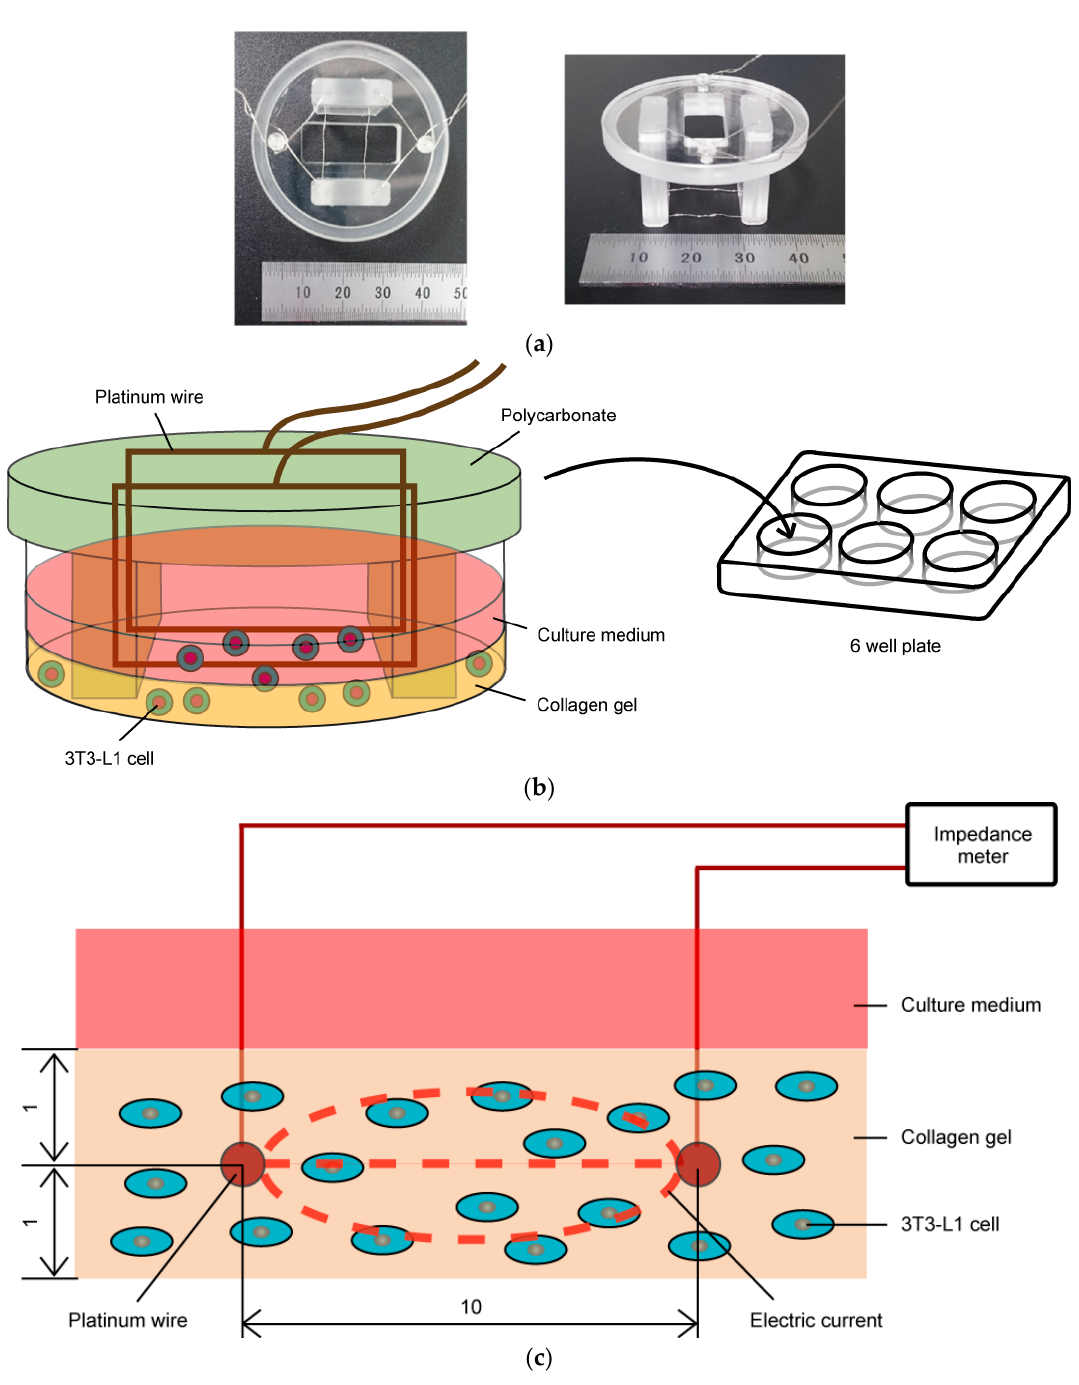
Figure 1. ( a ) Cell culture device for electrical impedance measurement. ( b ) Two platinum wires were fixed with a polycarbonate fixture and placed inside the 3T3-L1-cell-embedded collagen gel. It was placed within a 6-well cell-culture plate. ( c ) Cross-sectional view of the culture region of impedance measurement device. Voltage was applied between the two platinum wires.